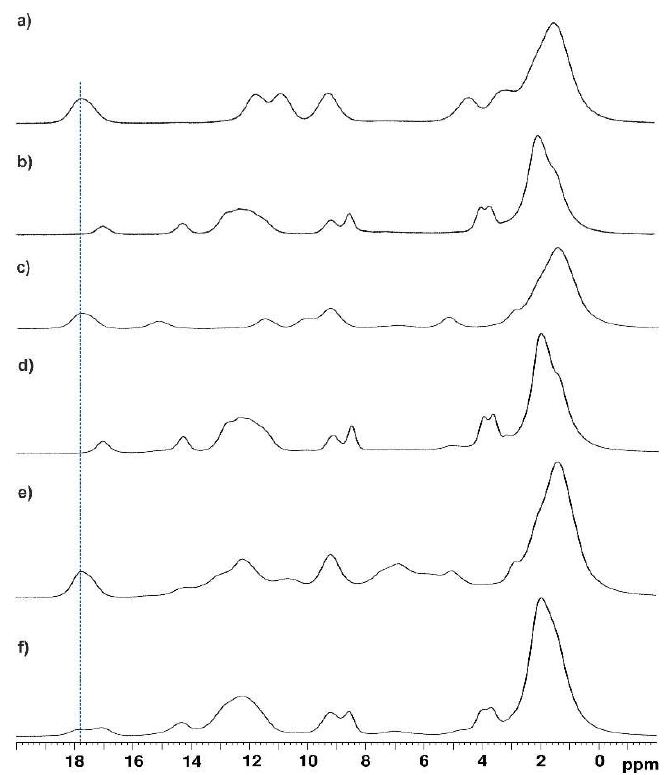
Figure 6. The 600.13 MHz 1 H VF/MAS spectra recorded with a spinning rate 60 kHz. Figures a, c and e show a physical mixture of HIMO and TBA in a ratio of 1:1. Figures b, d and f depict the spectra of samples after 1 h of grinding with MeOH as a LAG ( a ) HIMO and TBA crystallized from MeCN, mixture; ( b ) HIMO and TBA crystallized from MeCN, ground; ( c ) HIMO and TBA crystallized from EtOH, mixture; ( d ) HIMO and TBA crystallized from EtOH, ground; ( e ) HIMO and TBA crystallized from water, mixture; ( f ) HIMO and TBA crystallized from water, ground. The vertical blue line shows that the position of the O-H group of HIMO is not involved in interactions with TBA.